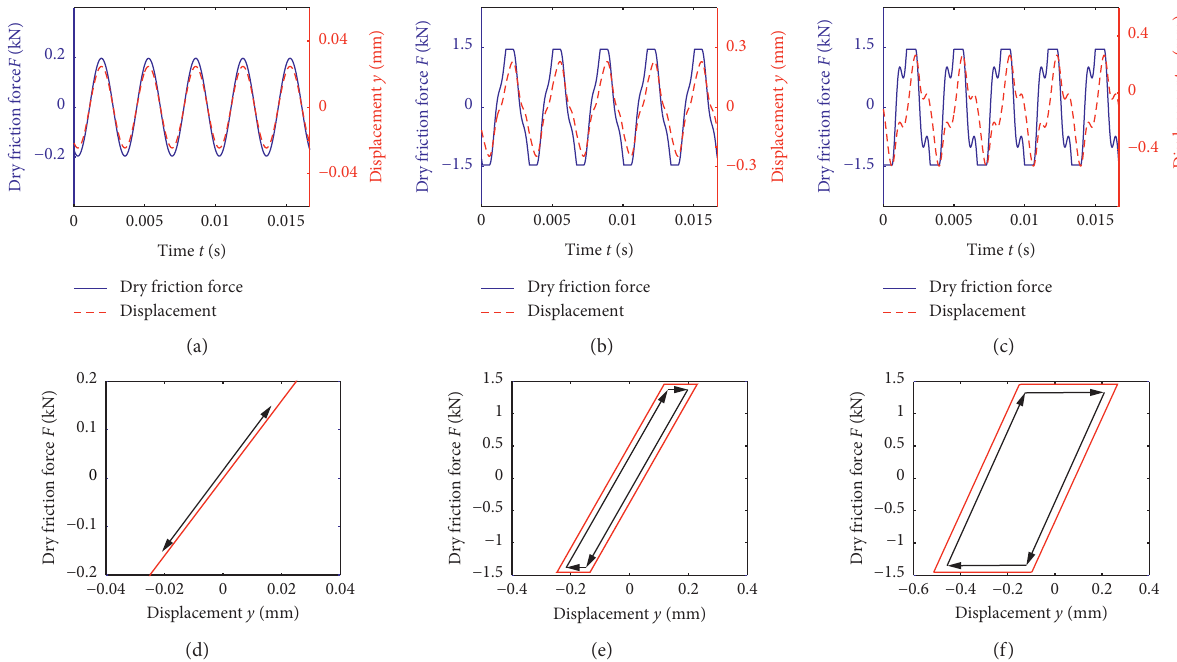
Figure 17: Dry friction force with respect to cases 1 ∼ 3: (a–c) represent the dry friction force curve and the response curve; (d–f) describe the hysteresis loop.